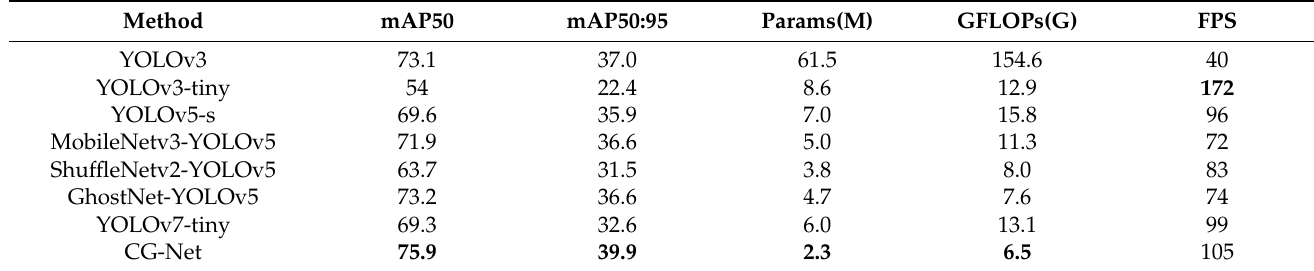
Table 5. Comparison with state-of-the-art methods on the NEU-DET dataset.